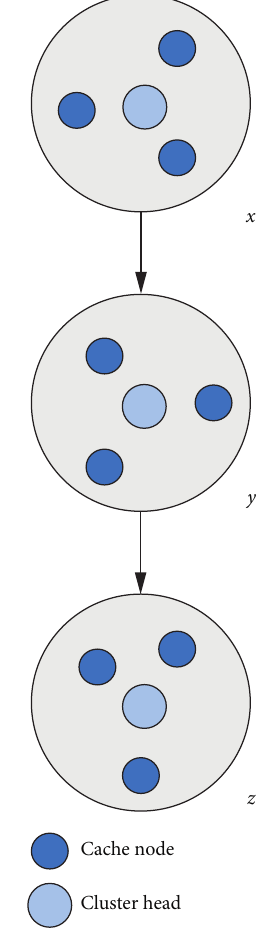
Figure 3: Network topological structure in the simulation environment.